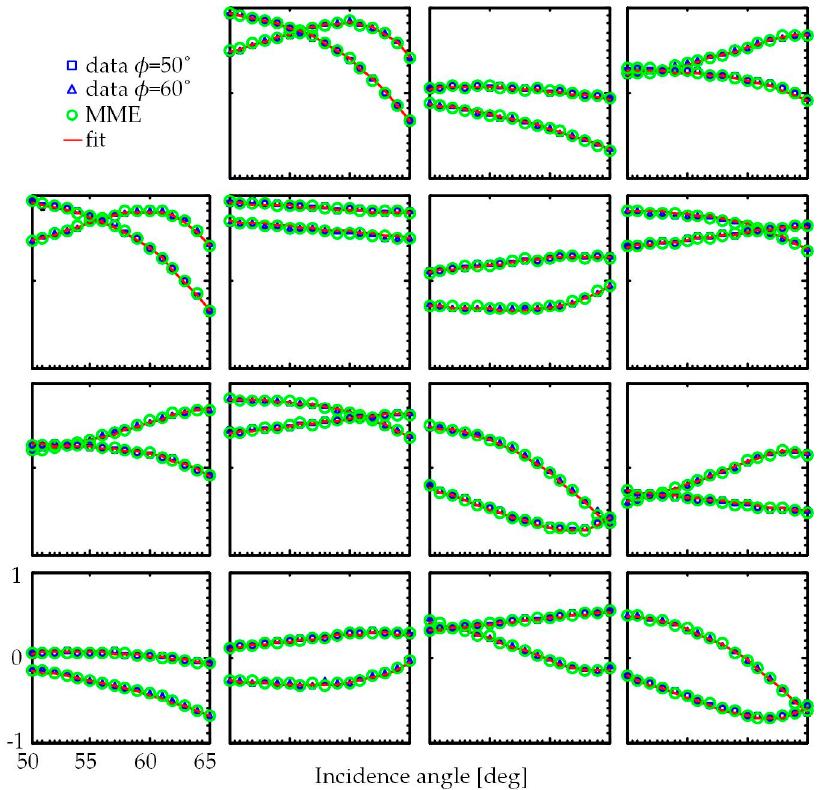
Figure 6. Fitting result of the measured and calculated best-fit Mueller matrices of the photoresist grating at the wavelength of 633 nm. The incidence angles varied from 50 ◦ to 65 ◦ at interval of 1 ◦ , and the azimuthal angles of 50 ◦ and 60 ◦ . The red solid lines represent the calculated best-fit data, the blue rectangles and blue triangles represent the TMS-measured data at the azimuthal angles of 50 ◦ and 65 ◦ , respectively. The green circles represent the corresponding MME-measured data for a comparison.